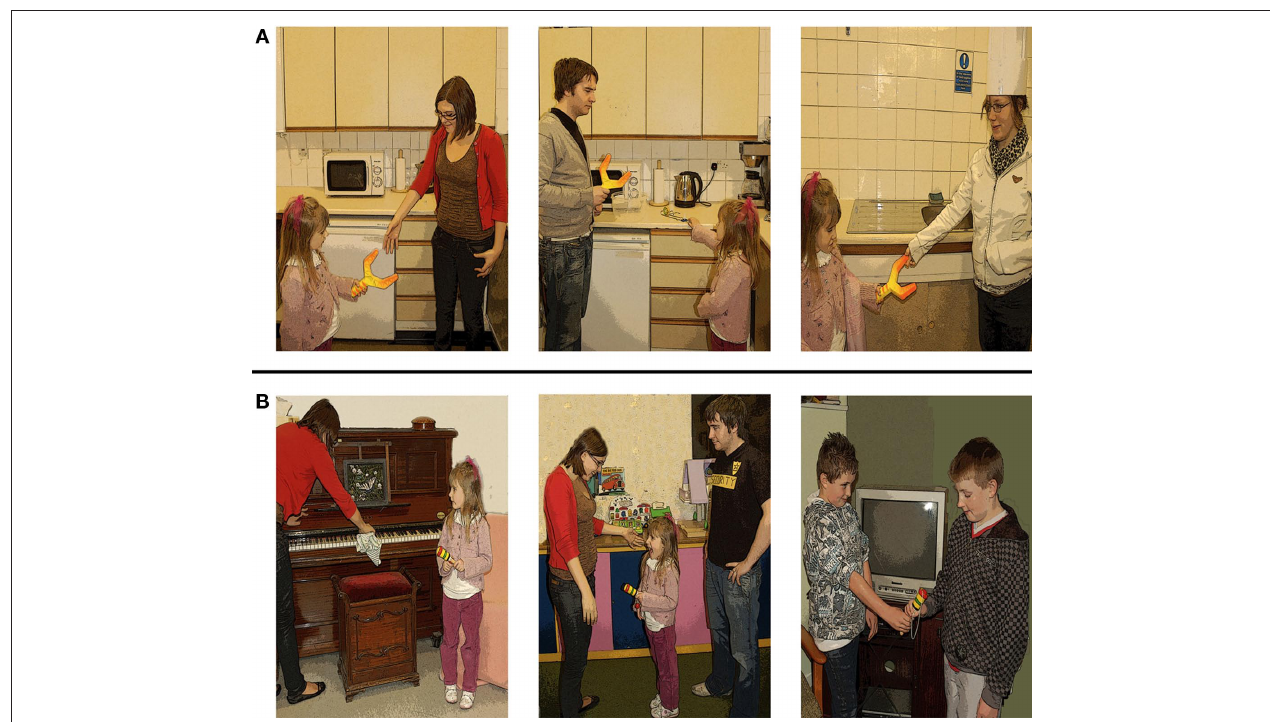
Figure 1 | examples of the pictures used in different books containing the tannin (A) or zorch (B). (A) From left to right, the pictures are from: The Very Naughty Puppy (p. 2), Rosie’s Bad Baking Day (p. 6), and Nosy Rosie at the Restaurant (p. 7) and (B) The Mystery Auntie (p. 3), Mischief at the Toyshop (p. 9), and I Don’t Want to Share! (p.